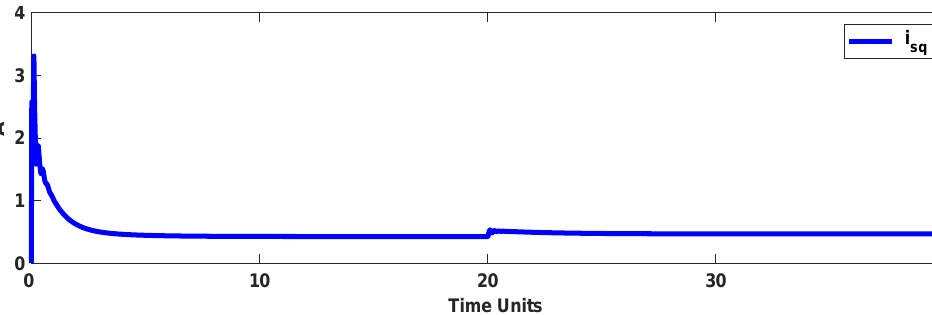
Figure 12. Stator current in the faulty condition